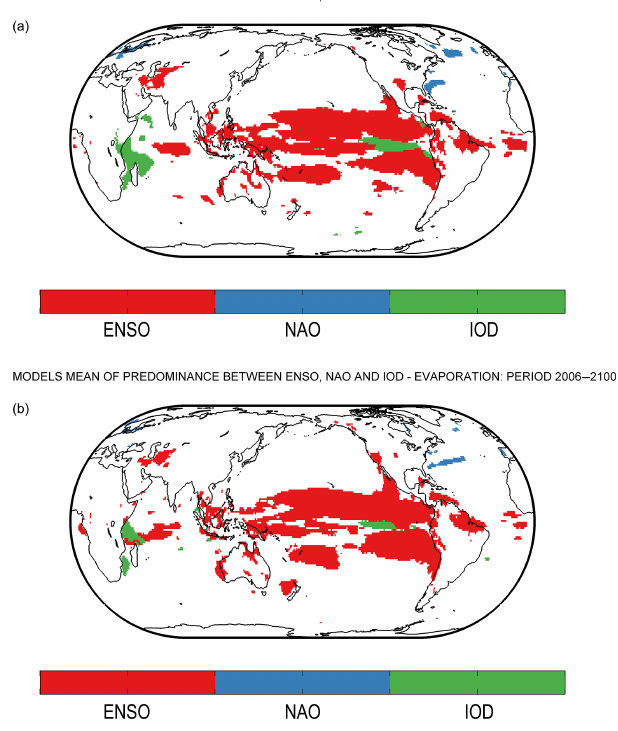
Figure 7. The predominance of a single climate mode on regional evaporation for periods 1906–2000 (a) and 2006–2100 (b) . The pre- dominance of a climate mode at a grid point is defined when the lowest p value of all climate modes (see also Figs. 1, 2 and 3) at the given grid point is less than 0.25 (i.e., climate modes are un- likely to have no causal effects on evaporation). The predominance of ENSO, NAO and the IOD on evaporation are shown in red, blue and green shades, respectively. ENSO: El Niño–Southern Oscilla- tion. NAO: North Atlantic Oscillation. IOD: Indian Ocean